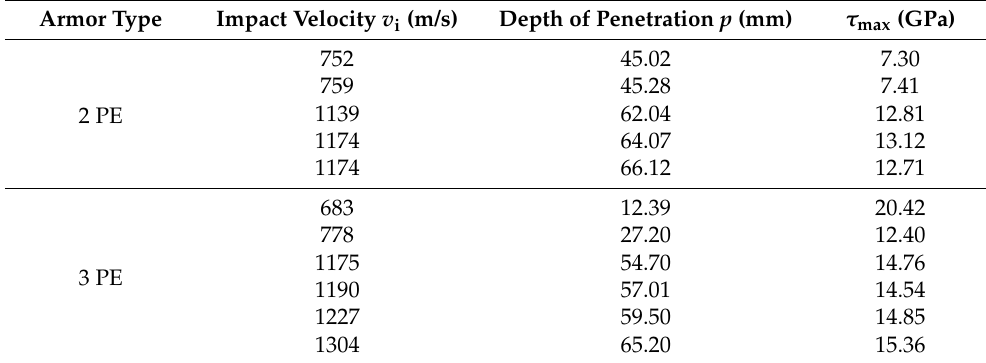
Figure 13. Schematic diagram of the two-stage penetration composed of shearing and bulging stages. Table 13. Depth of penetration for estimating through-thickness shear strength.